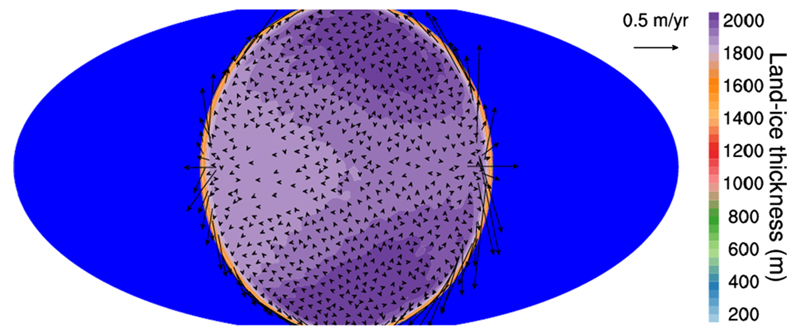
Ice sheets over a supercontinent spanning the entire nightside. Color shading indicates ice-sheet thickness, and arrows indicate ice-sheet flow velocity. Geothermal flux is 0.1 W m−2 in the simulation. Adapted from Yang et al. (2014)